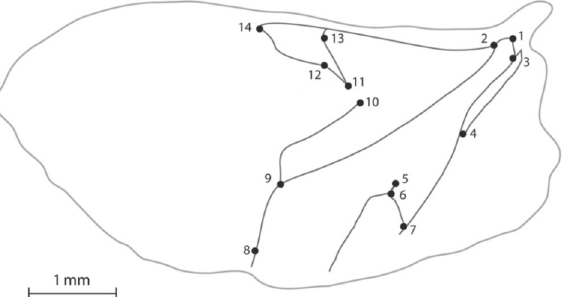
Figure 1. Representation of the 14 morphological landmarks identified on the hindwings of western corn rootworm [61].